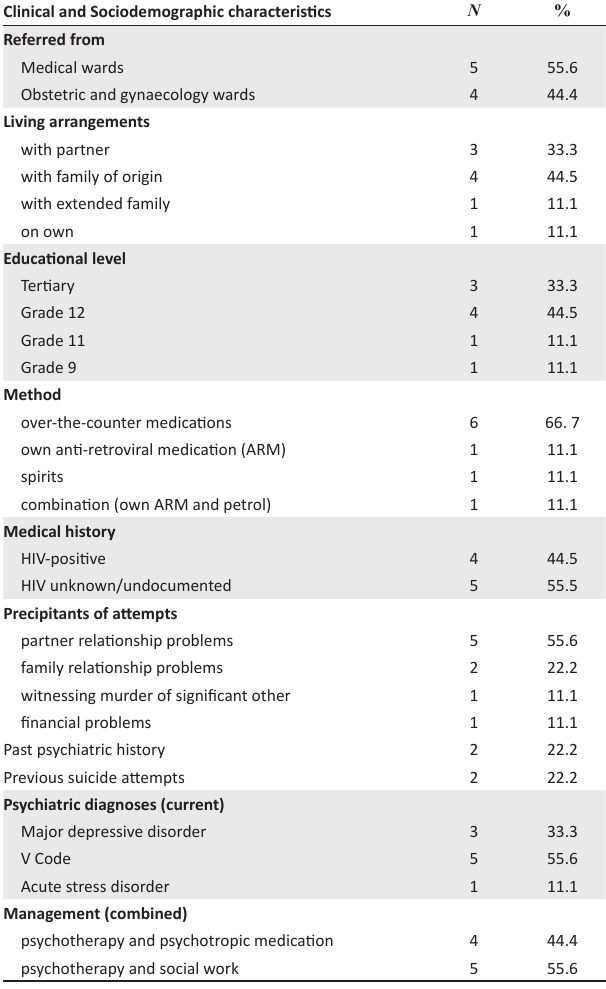
TABLE 1: Clinical and sociodemographic characteristics. Clinical and Sociodemographic